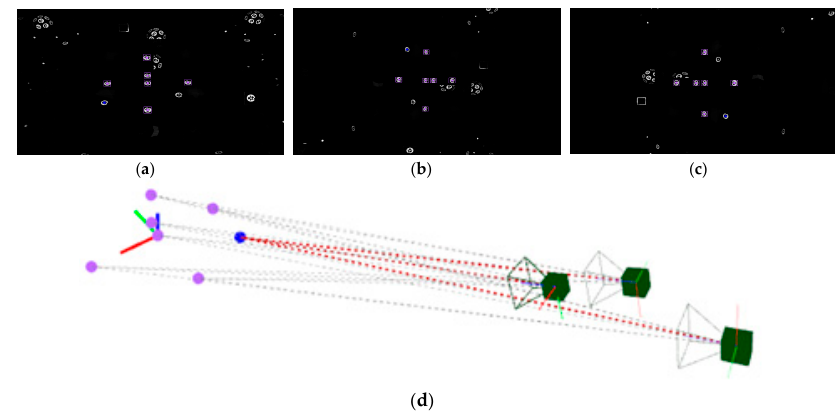
Figure 8. Computing of initial approach of a new target X i coordinates. A coded target is detected (highlighted in blue) in each image ( a – c ), where images corresponds to those three in Figure 7. Computed target coordinates are depicted in 3D scene ( d ) (in blue), along with the three epipolars from the images to the detected target. Along with computing the new target X i coordinates, new camera extrinsic parameters also